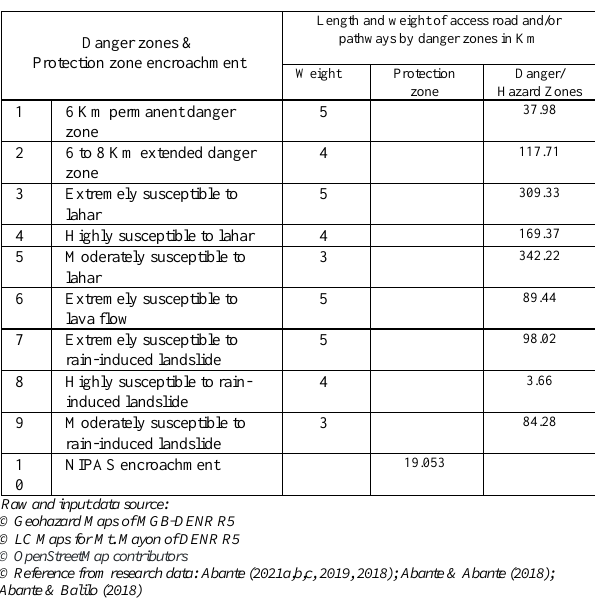
Table 1. Length of access road and/or